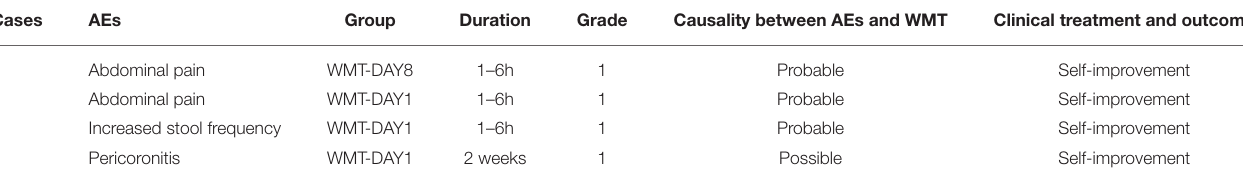
TABLE 2 | Washed microbiota transplantation (WMT)-related adverse events (AEs) during the 1 month